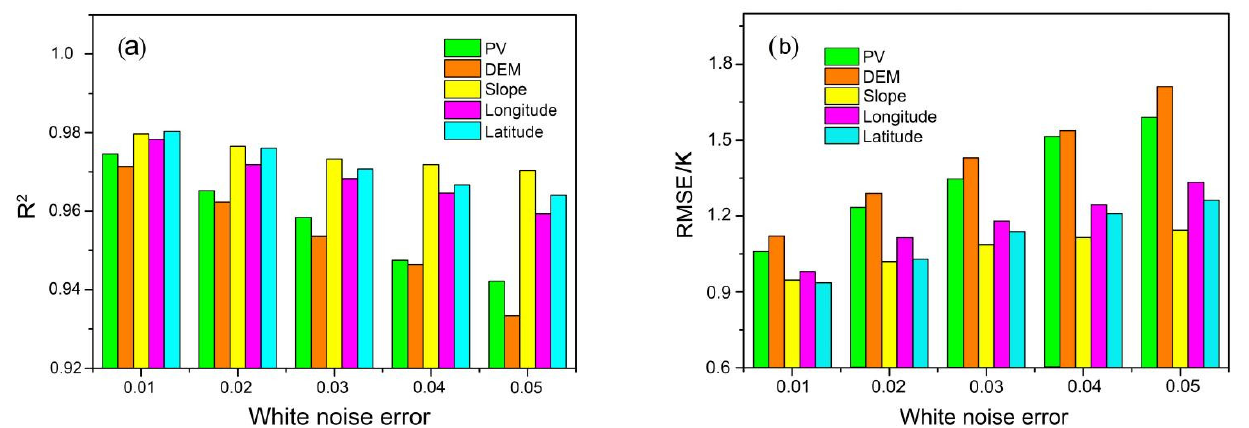
Figure 4. The R 2 and RMSE change in PV, elevation, slope, longitude, and latitude when five predictors have white noise errors from 0.01 to 0.05: ( a ) R 2 , ( b ) RMSE. R 2 and RMSE values were calculated using the predicted LSTs and MODIS LSTs in Image